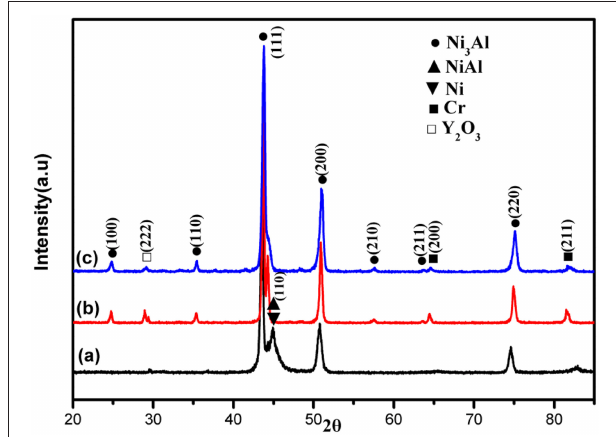
FIGURE 2 | XRD patterns of NiCrAlY coating: (a) as-sprayed, (b) heat-treated at 900 ◦ C, and (c) heat-treated at 1,100 ◦ C.